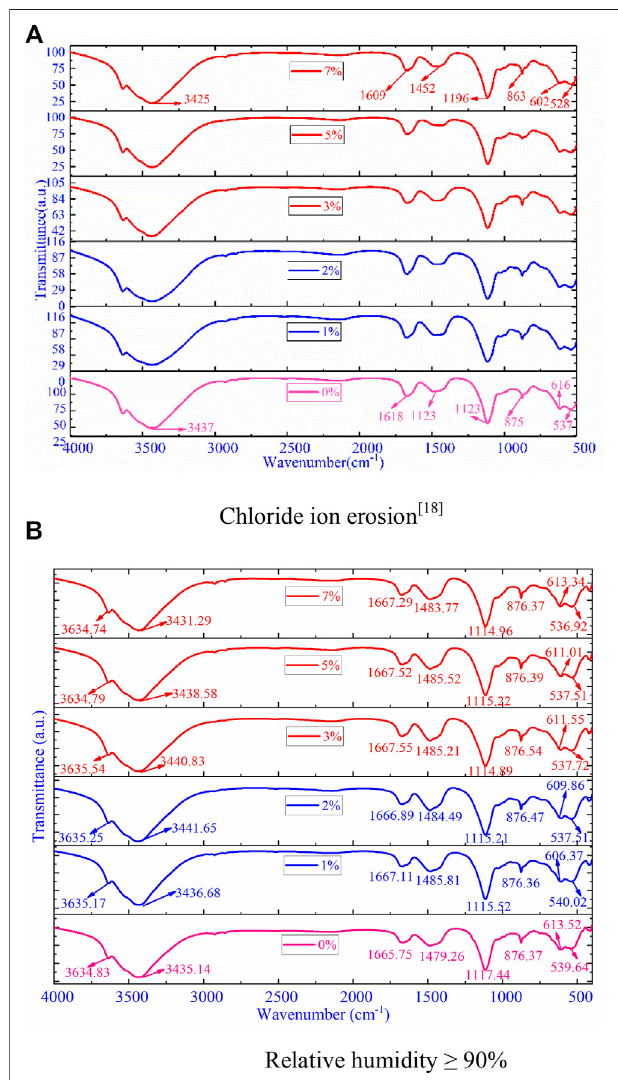
FIGURE 1 | FT-IR spectra curves with different erosion environments of grouting materials for 7d. (A) Chloride ion erosion [18] . (B) Relative humidity ≥